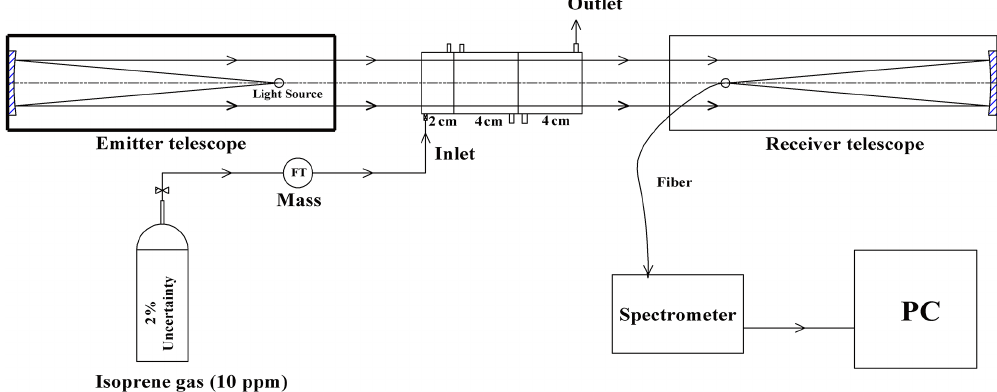
Figure 3. The scheme of the calibration system.